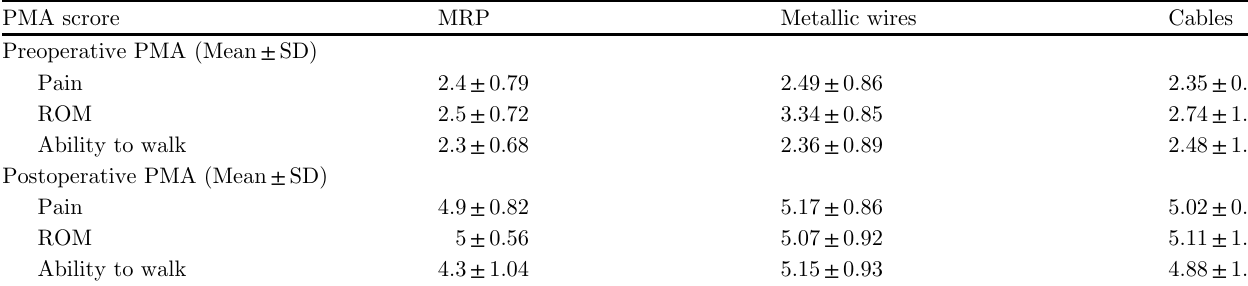
Table 3. Clinical scores.